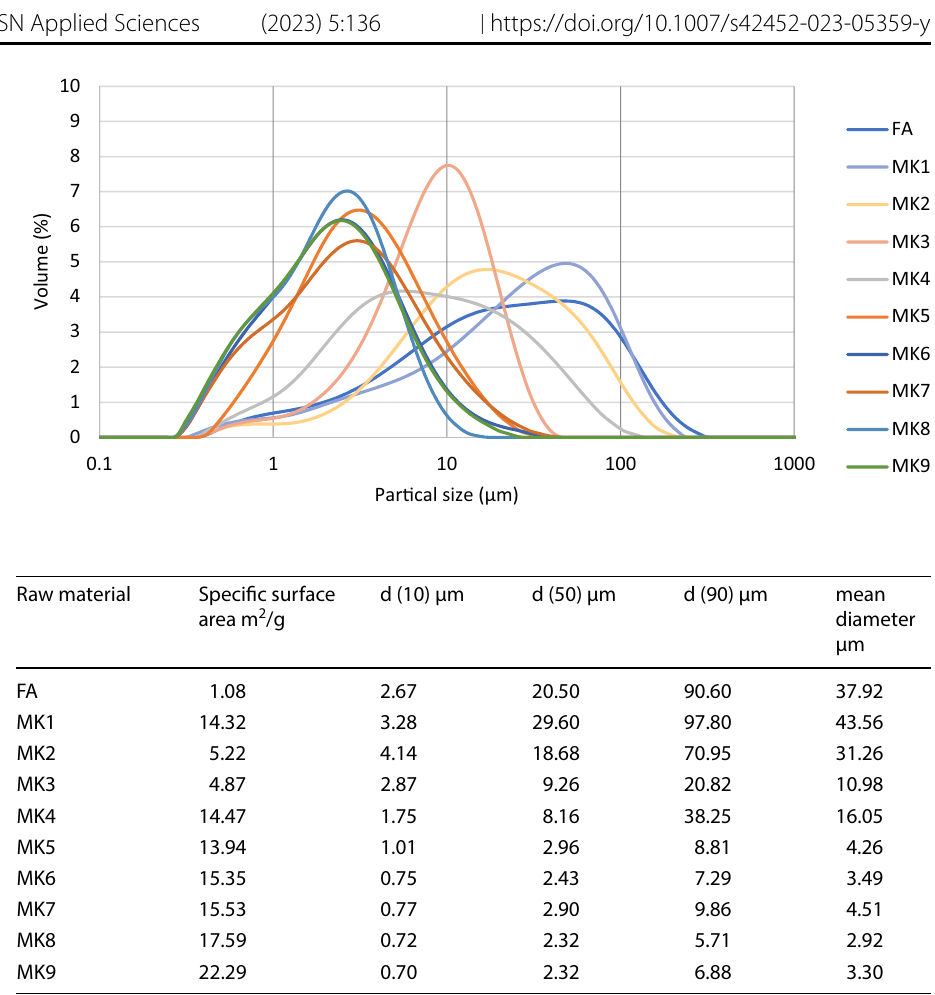
Table 2 Specific surface area according to BET and diameter characteristics of FA and